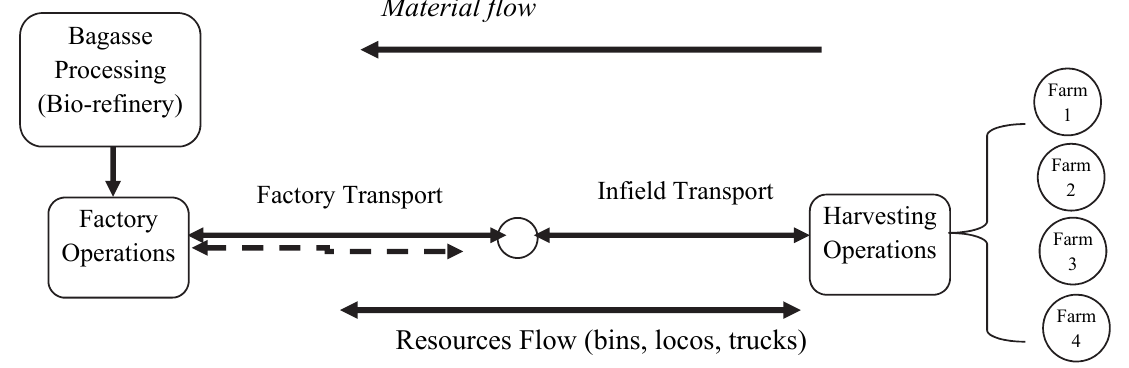
Fig. 1. Existing sugarcane biomass supply chain